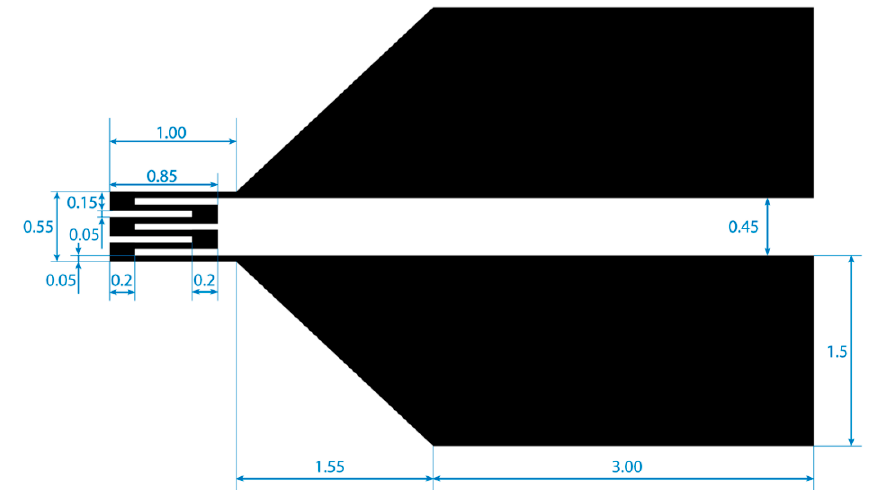
Figure 4. Dimension of a strain gauge in mm.